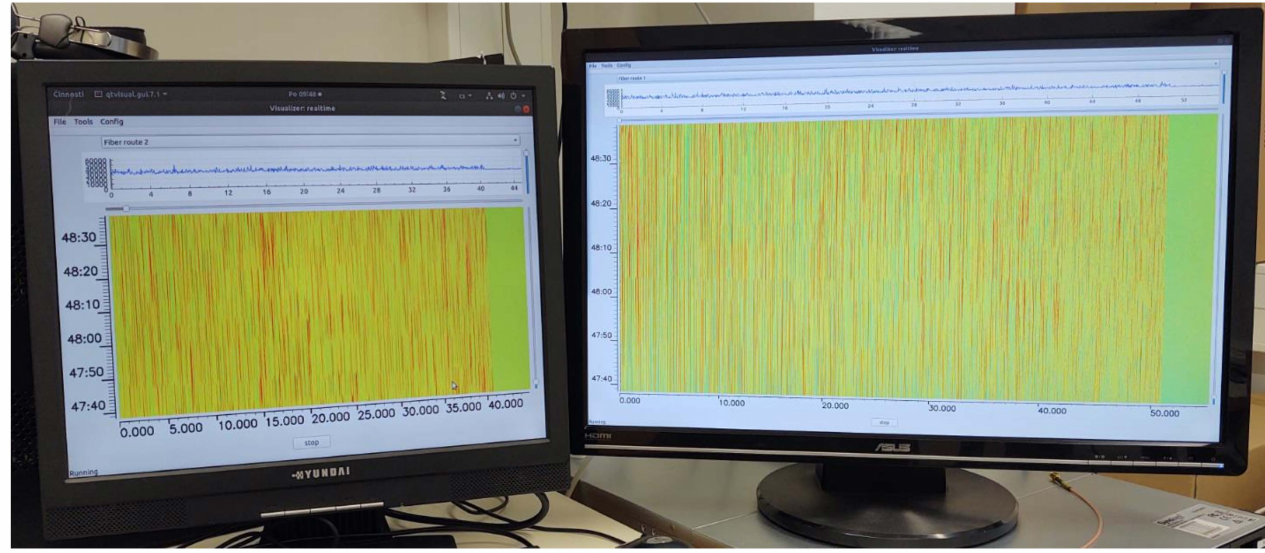
Figure 25. Raw waterfalls from the two sensing fibers—40 and 50 km